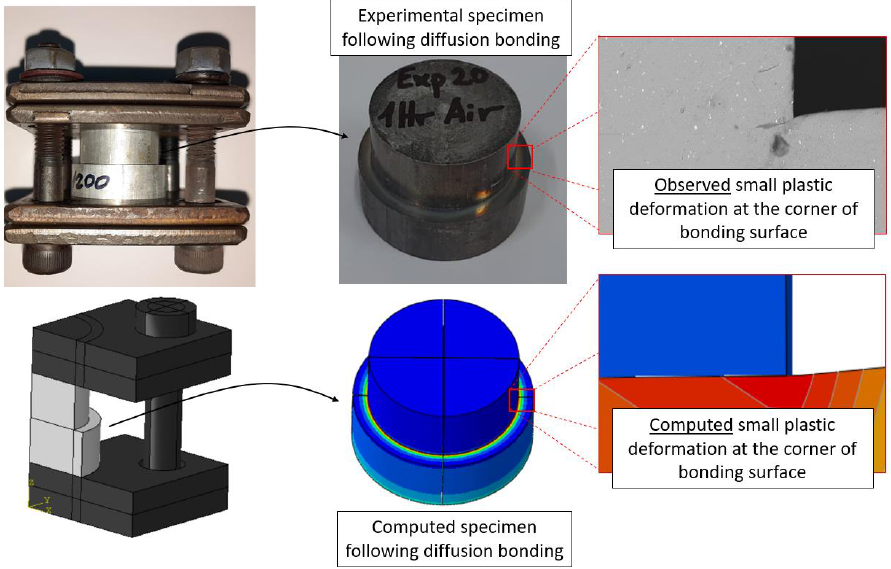
Figure 10. Computed vs. Observed local deformation at the bonding interface corner following the diffusion bonding process.